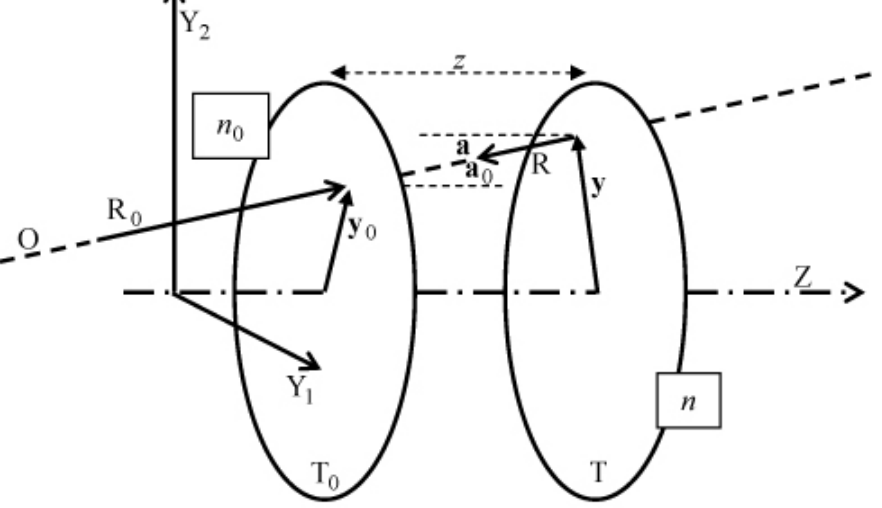
Figure 2 An optical axis O and entrance T 0 and exit T planes of an odd-catadioptric system. The incident and emergent segments of a ray lie on O but point in opposite directions. Notice that emergent segment R is in a medium of index n in both this figure and Figure